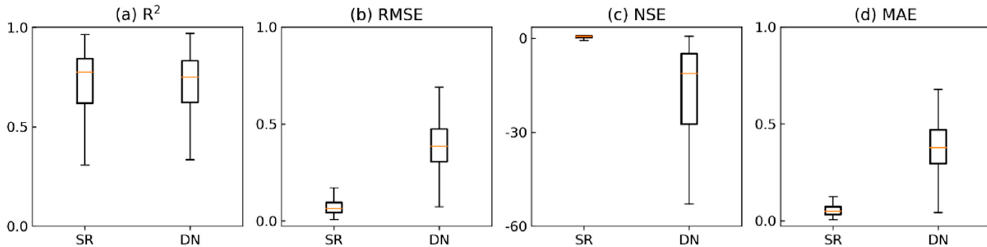
Figure 9. Results of NDVI validation for 150 sites: (a) coefficient of determination, (b) root mean square error, (c) Nash–Sutcliffe efficiency, and (d) mean absolute error.